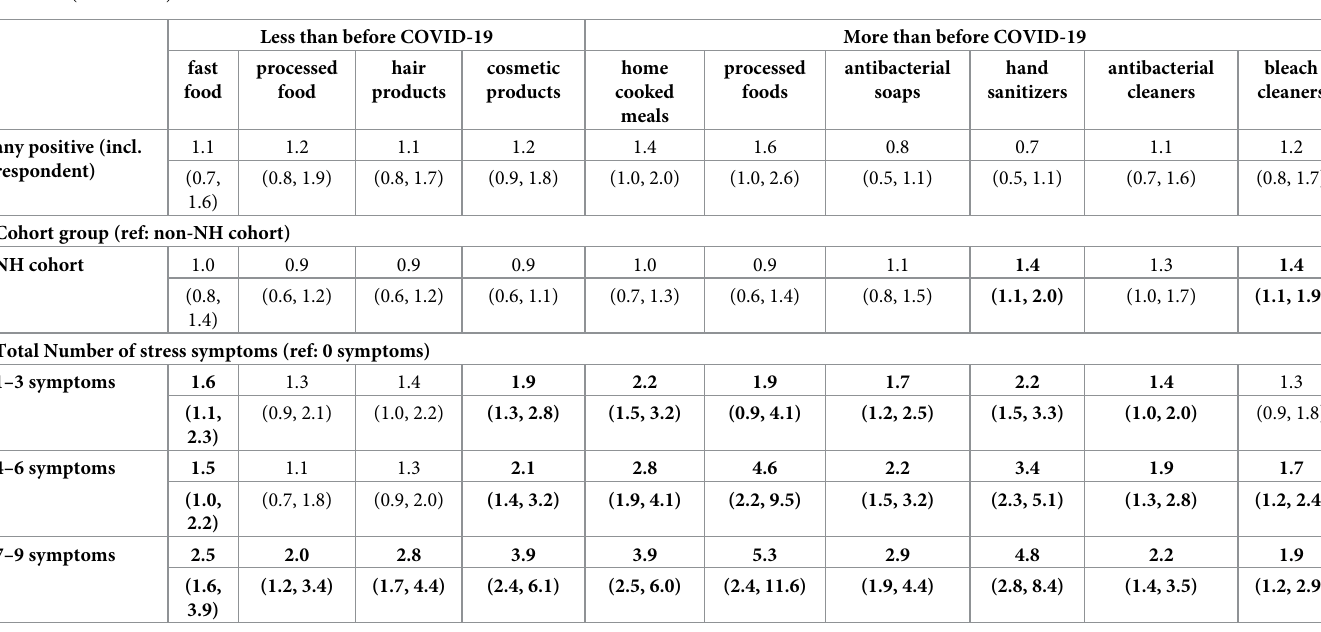
associated with using fewer hair products and fewer make-up products ( Table 2